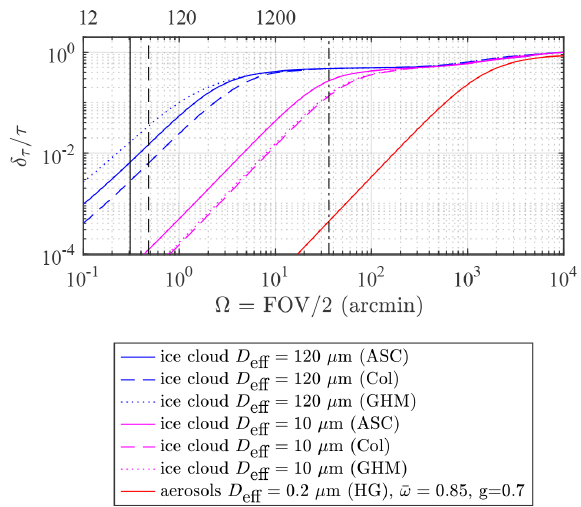
Figure 14. The relative forward-scattering error for typical aerosols and ice clouds, as a function of the half field of view. The vertical black lines correspond to SPST09/C11 (solid line), SPST05/M703 (dashed line), and Cimel sun/moon photometers (dot-dashed line). The acronyms in parentheses specify the phase function